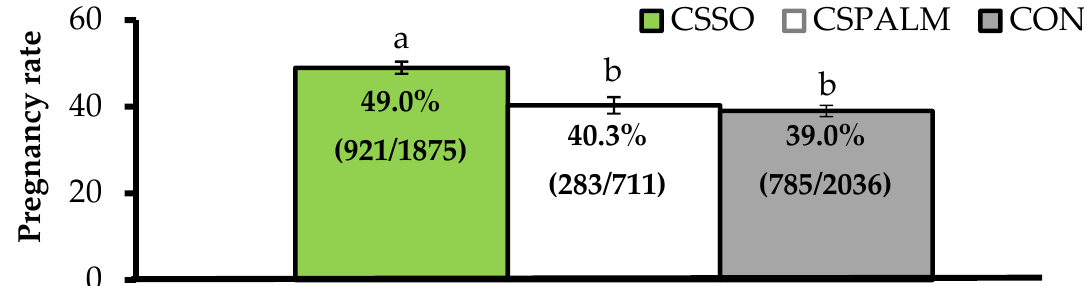
Figure 1. Pregnancy rates (as %) after artificial insemination in beef cows receiving Ca soaps of soybean oil (CSSO), Ca soaps of palm oil (CSPALM), or CON (unsupplemented) for 28 days after AI [15,16]. All values reported are least square means ± standard error (represented as error bars). Means with different superscripts differ ( p ≤ 0.05). Information within parentheses indicate number of pregnant cows/total cows inseminated.